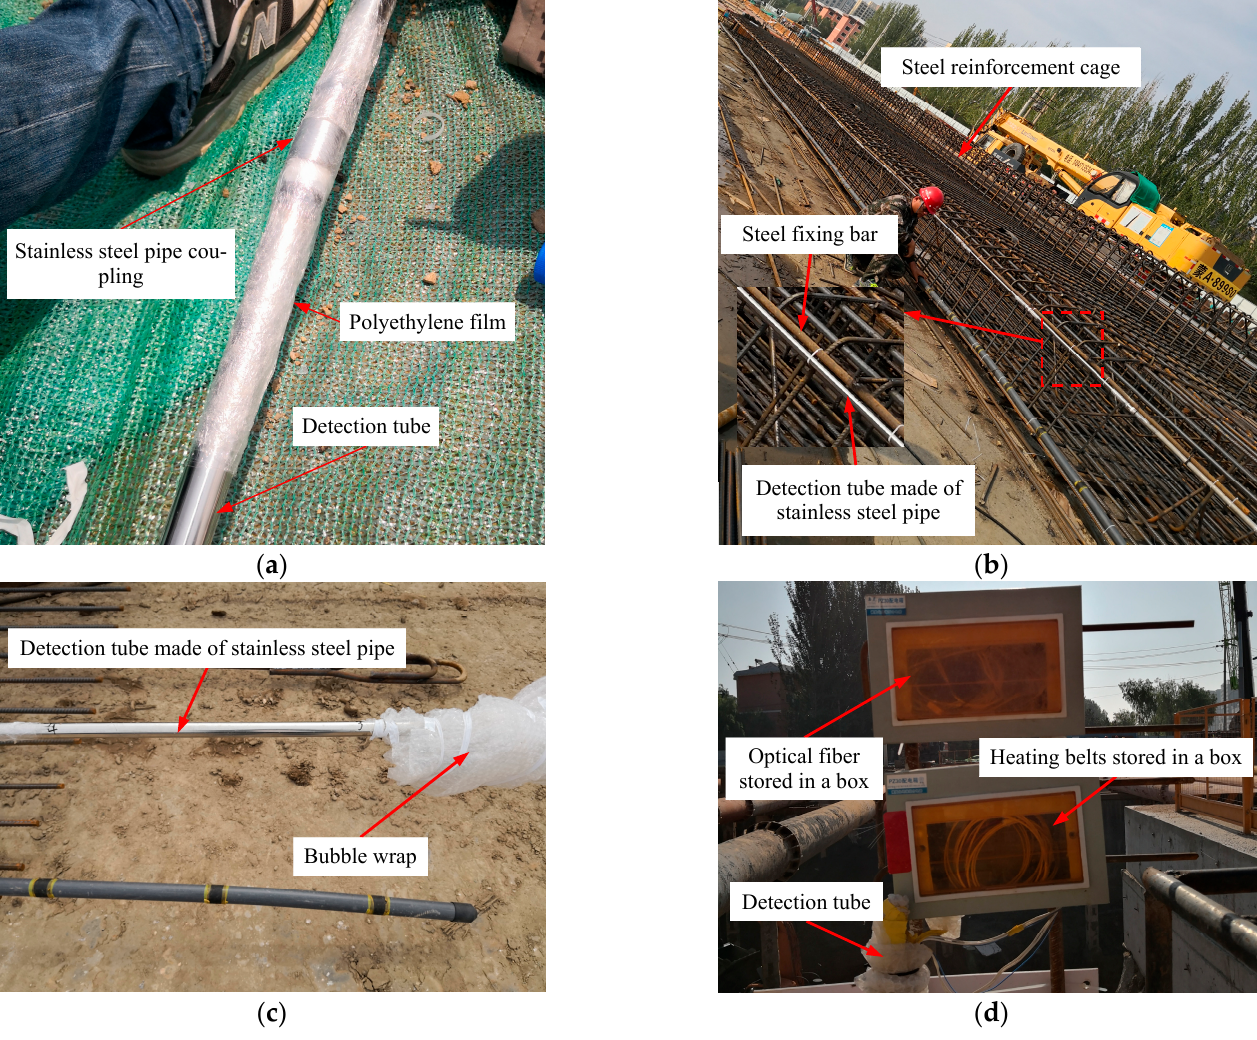
Figure 10. Photographs showing some of the installed parts of the detection system at L1: ( a ) a coupling tube between two adjacent short pipes wrapped in polyethylene (PE) film; ( b ) the detection tube fixed to the reinforcement cage; ( c ) cables outside the detection tube protected by bubble wrap; ( d ) detection point L1 after the installation of the facilities had been finished.